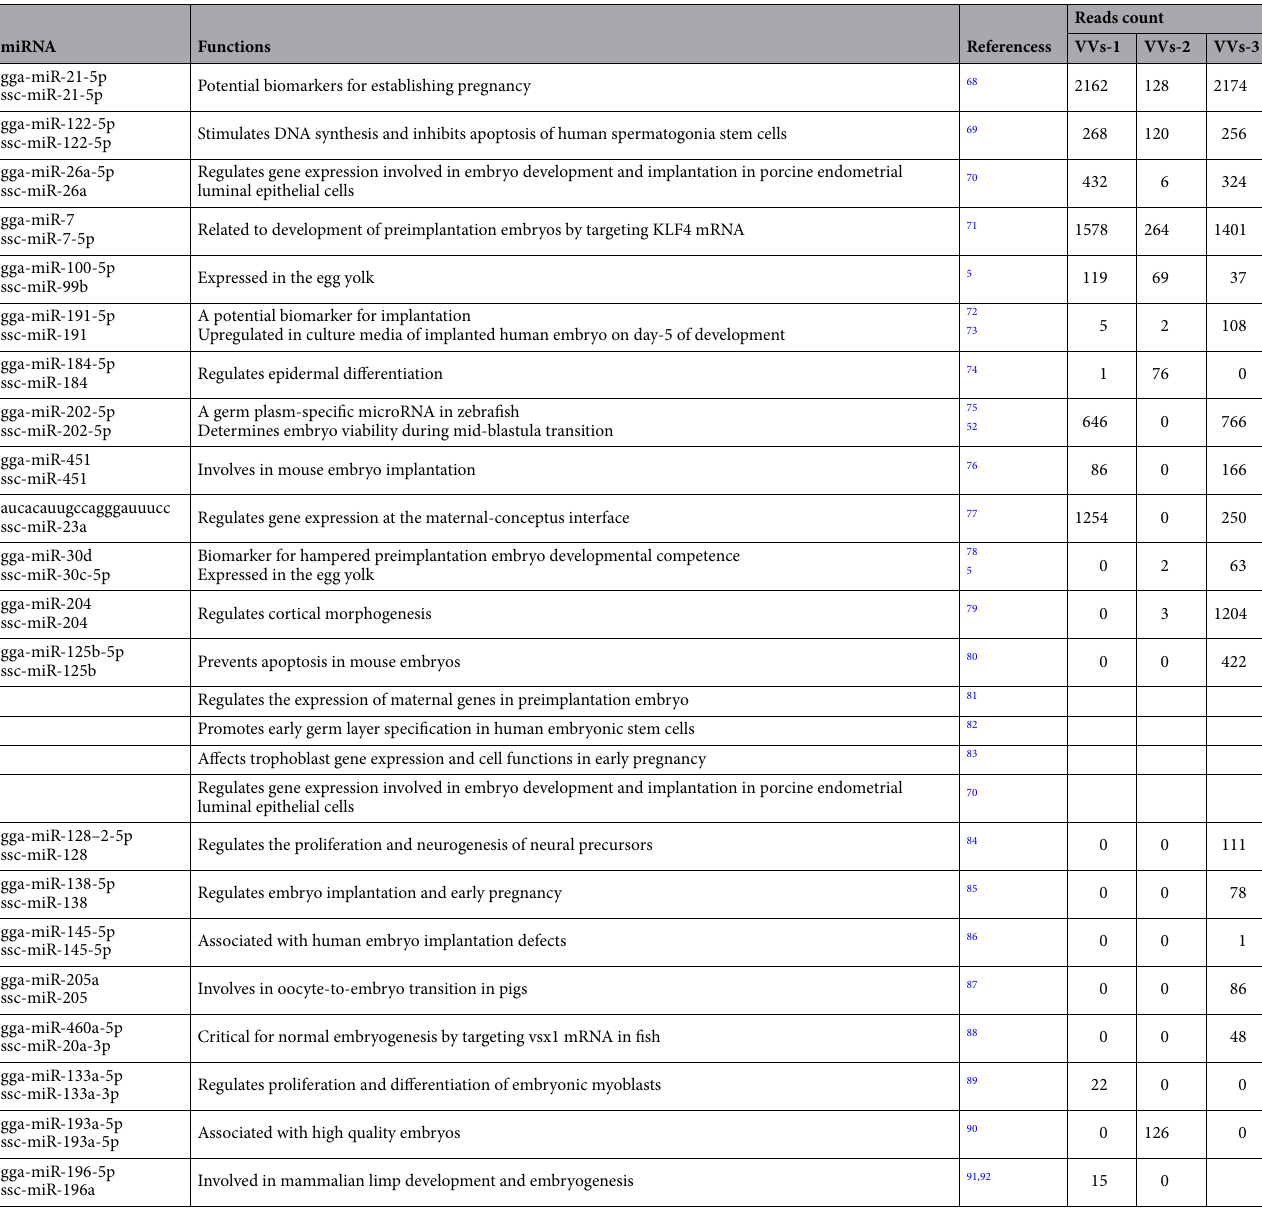
Table 3. Mature and novel chicken ( Gallus , gga) miRNAs detected in VVs with their ortholog porcine ( Sus scrofa , scc) miRNA and their functions related to the development of embryos and stem